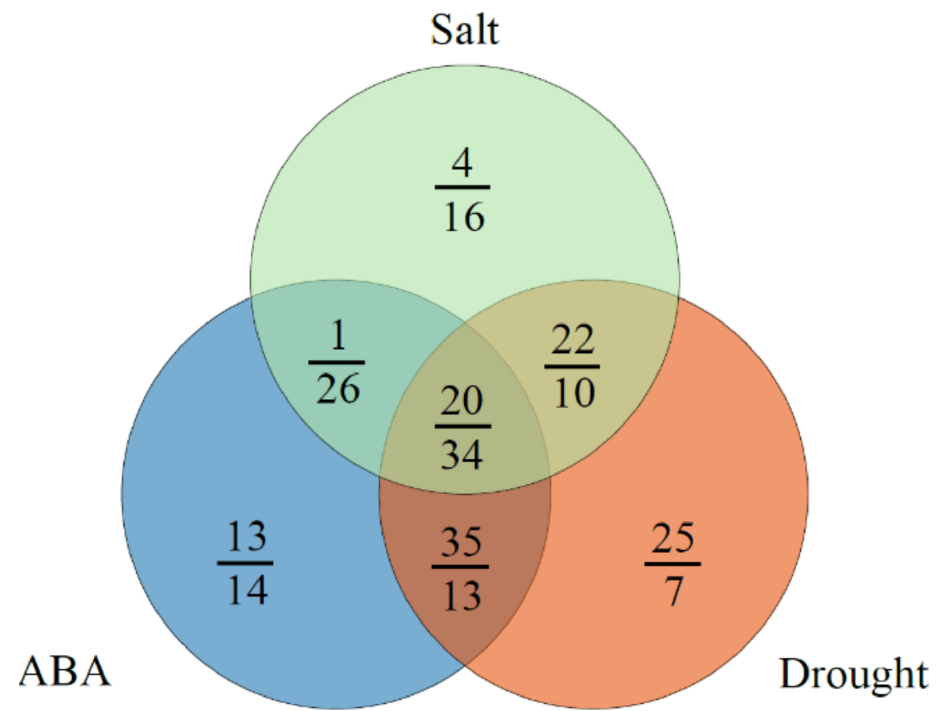
Figure 4. Venn diagram showing the overlap of differentially expressed MaUGT genes under ABA and abiotic stress. The letters on the line and below the line indicate the differentially expressed MaUGT gene numbers in the shoots and roots,